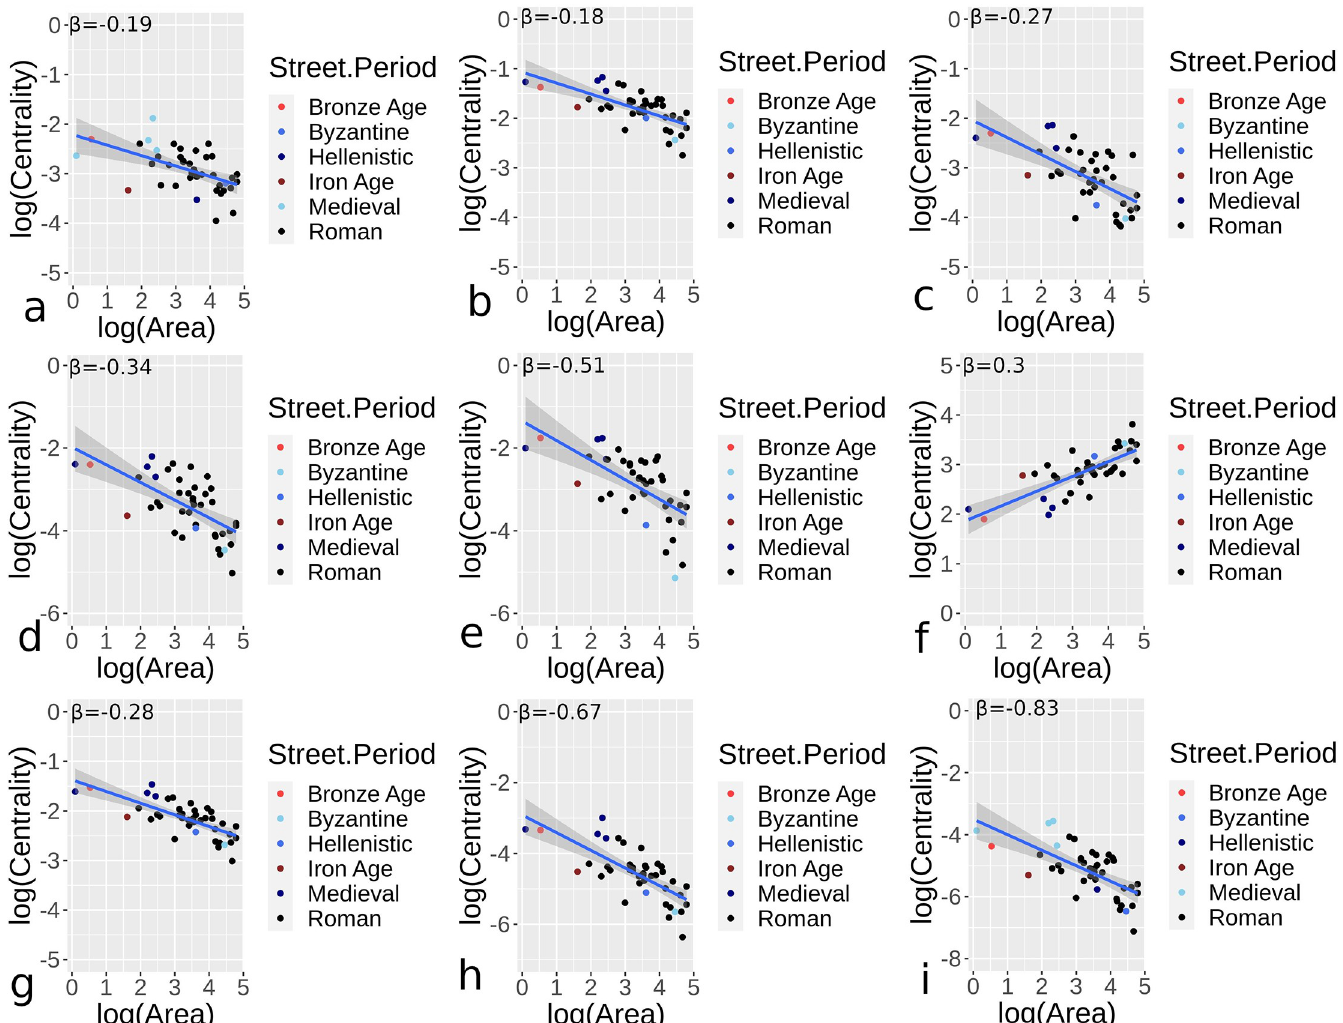
Fig 7. Centrality and area scaling values for urban settings in different periods and for all nearly complete or complete street networks for orthogonal street networks. Results demonstrate betweenness (a), closeness (b), degree (c), efficiency (d), eigenvector (e), harmonic (f), Katz (g), straightness (h), and current flow (i) centrality